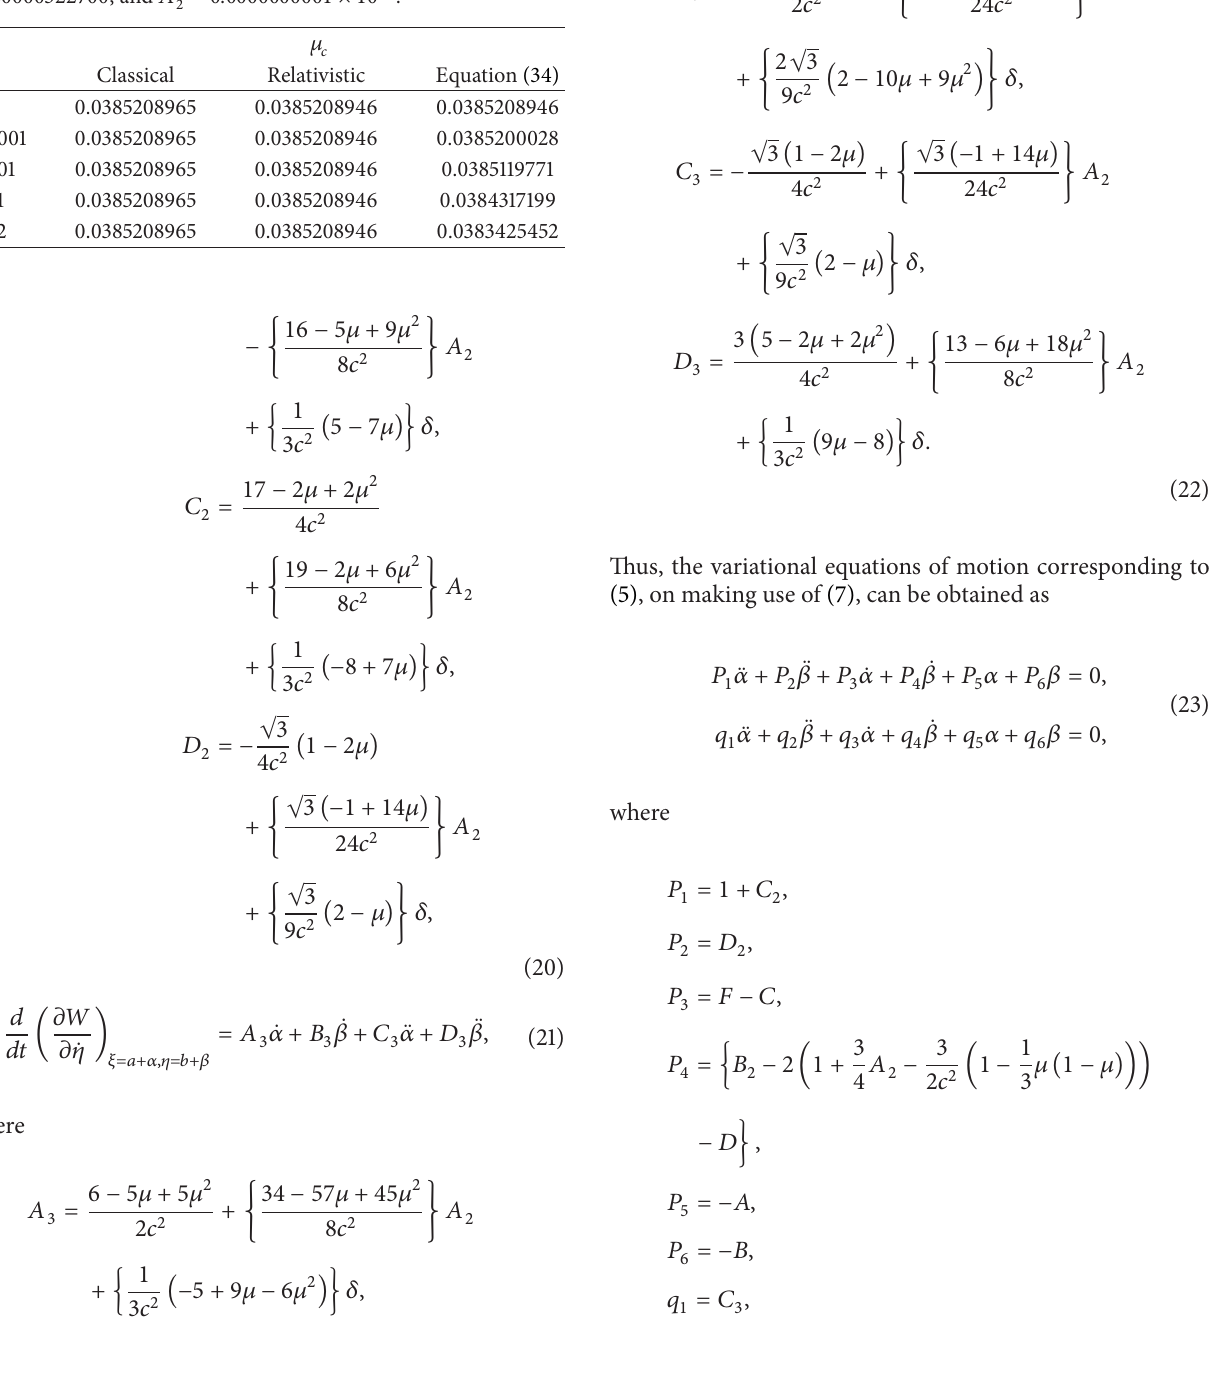
Table 2: Critical Mass for the Sun-Mars system: 𝑐 = 12424.24 , 𝜇 = = 0.0000000001 × 10 −8 0.000000322700 , and 𝐴 2